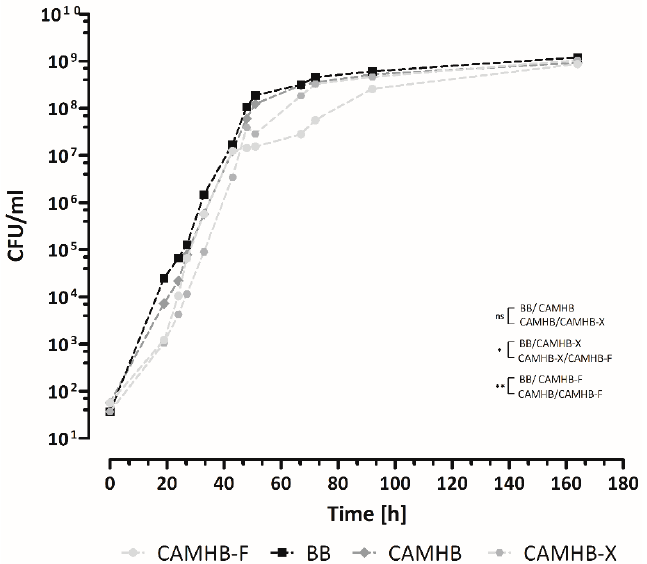
Figure 3. Growth curve of the B. melitensis reference strain ATCC 23456 in four different culture media (BB, CAMHB, CAMHB-F, CAMHB-X). Each dot represents the mean value of three replicates. The differences between the culture media were analyzed by determining the area under curve (AUC) prior to analysis by one-way ANOVA test. The error bars indicate the interquartile range (IQR) from the median. The asterisks represent statistically significant differences between groups. The best growth was obtained when using BB. CAMHB was only slightly inferior to BB after 48 h (6 × 10 7 CFU/mL vs. 1.07 × 10 8 CFU/mL), whereas the growth rates in CAMHB-F and CAMHB-X were considerably lower (1.44 × 10 7 CFU/mL vs. 3.92 × 10 7 CFU/mL). After 72 h of incubation, the measured CFU/mL were identical for BB, CAMHB and CAMHB-X, whereas CAMHB-F showed 10- times-lower CFU/mL counts. After 164 h, the cultures in all of the media had reached the stationary phase with identical CFU counts (~10 9 CFU/mL). ns, non-significant; * p < 0.5; ** p <